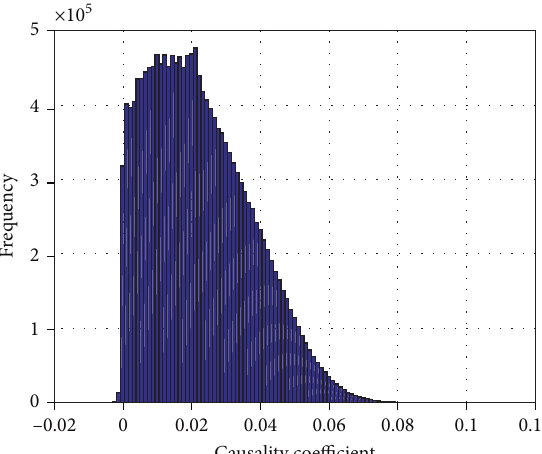
Figure 9: Distribution of causality